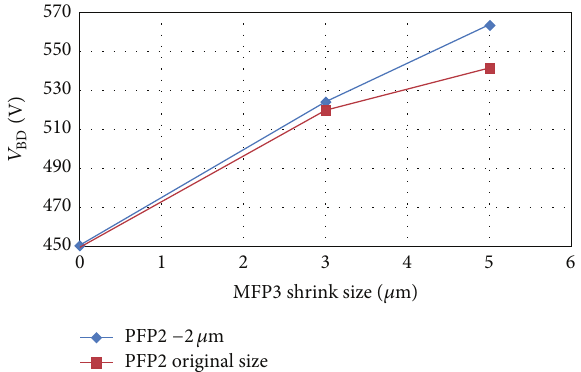
Figure 6: NLDMOS breakdown voltage related to MFP3 reducing sizes for different PFP2 length.